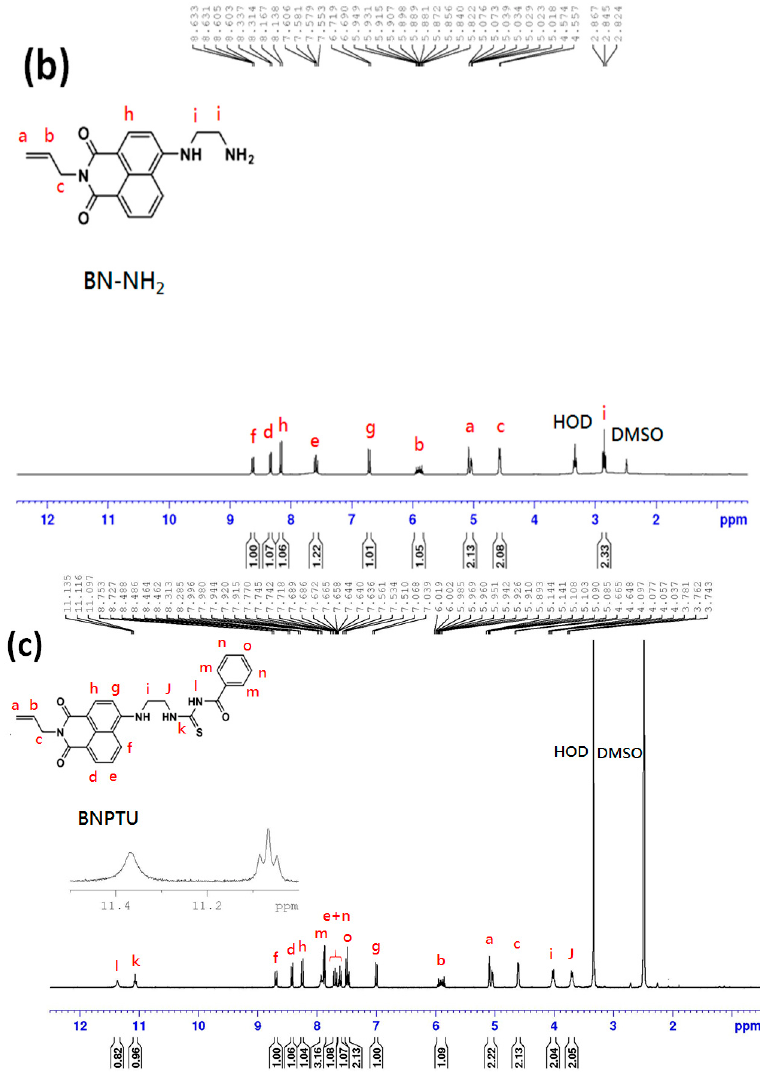
Figure 3. 1 H - NMR spectra recorded for ( a ) BN-Br in CDCl 3 , ( b ) BN-NH 2 in DMSO- d 6 , and ( c ) BNPTU monomer in DMSO- d 6 .